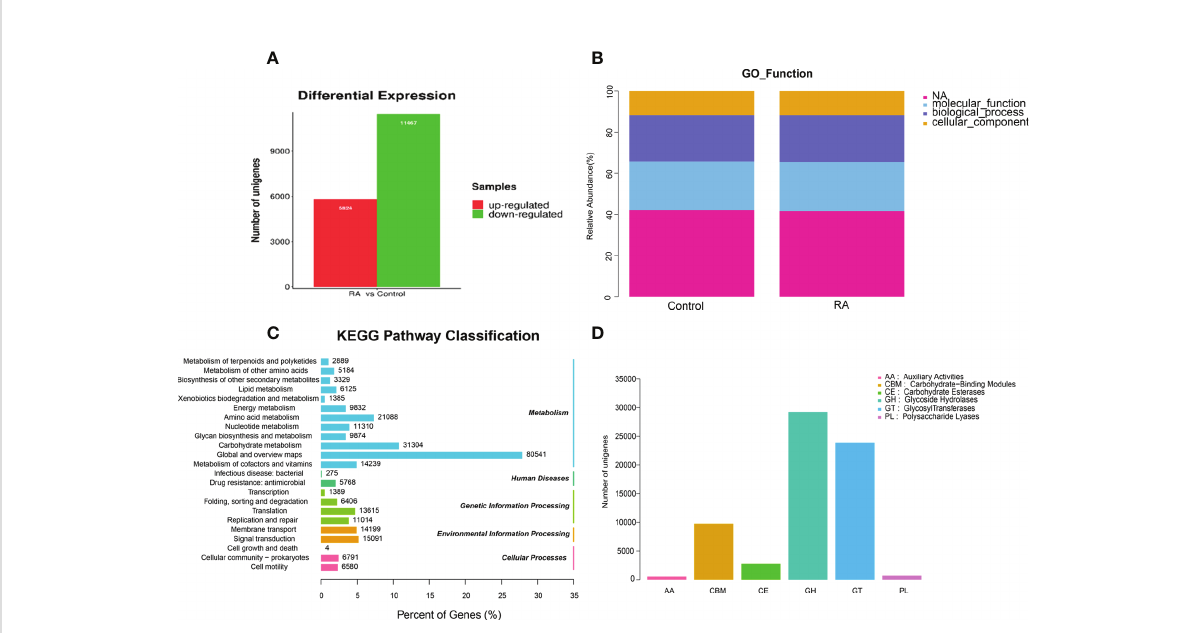
FIGURE 5 The differential gene expression and gene function in RA and control group. (A) Differentially expressed unigenes between RA and control groups. (B) Relative abundance of GO function. (C) KEGG pathway classi fi cation. (D) CAZy